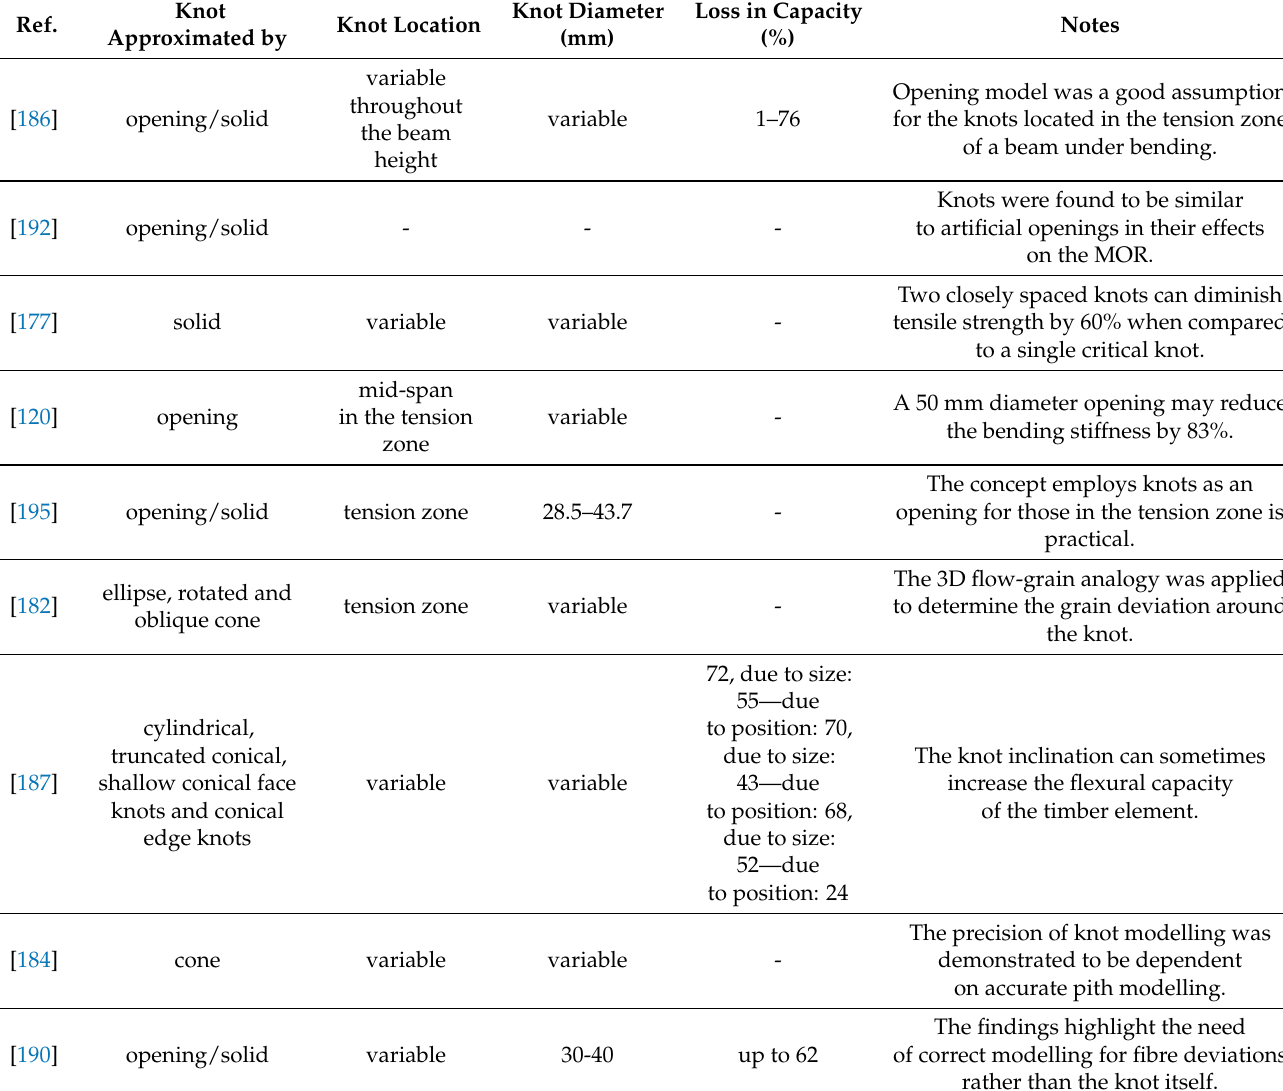
Table 4. Experimental and numerical studies on the effects of knots in structural